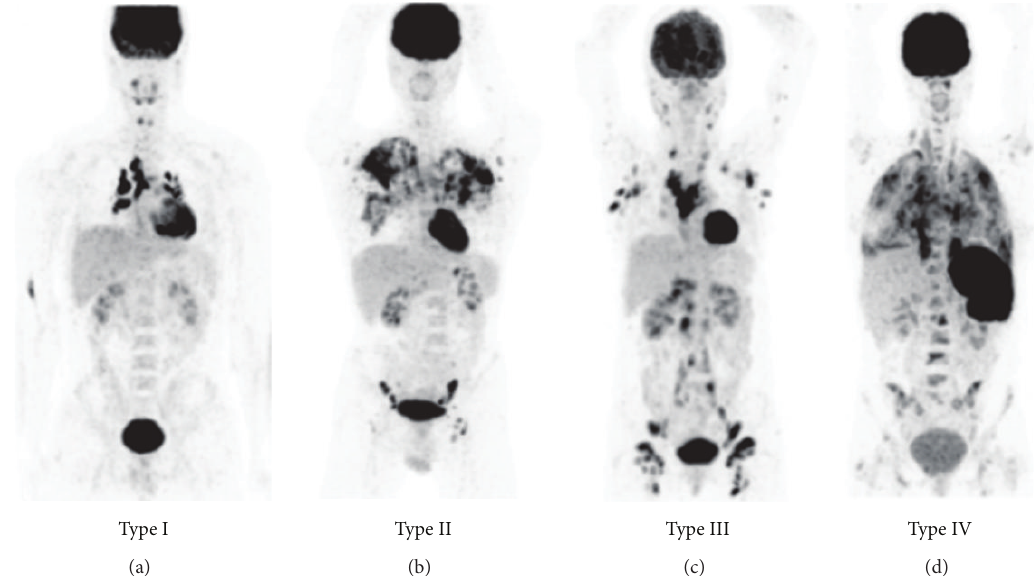
Figure 2: FDG-PET classification of sarcoidosis. Type I: thoracic lymph node involvement (in this image: mediastinal and hilar regions), type II: involvement of the lung parenchyma, type III: diffuse lymph node involvement (in this image all lymph node regions of the body are involved), and type IV: organ involvement (in this image involvement of the spleen and bones) (images courtesy by R.